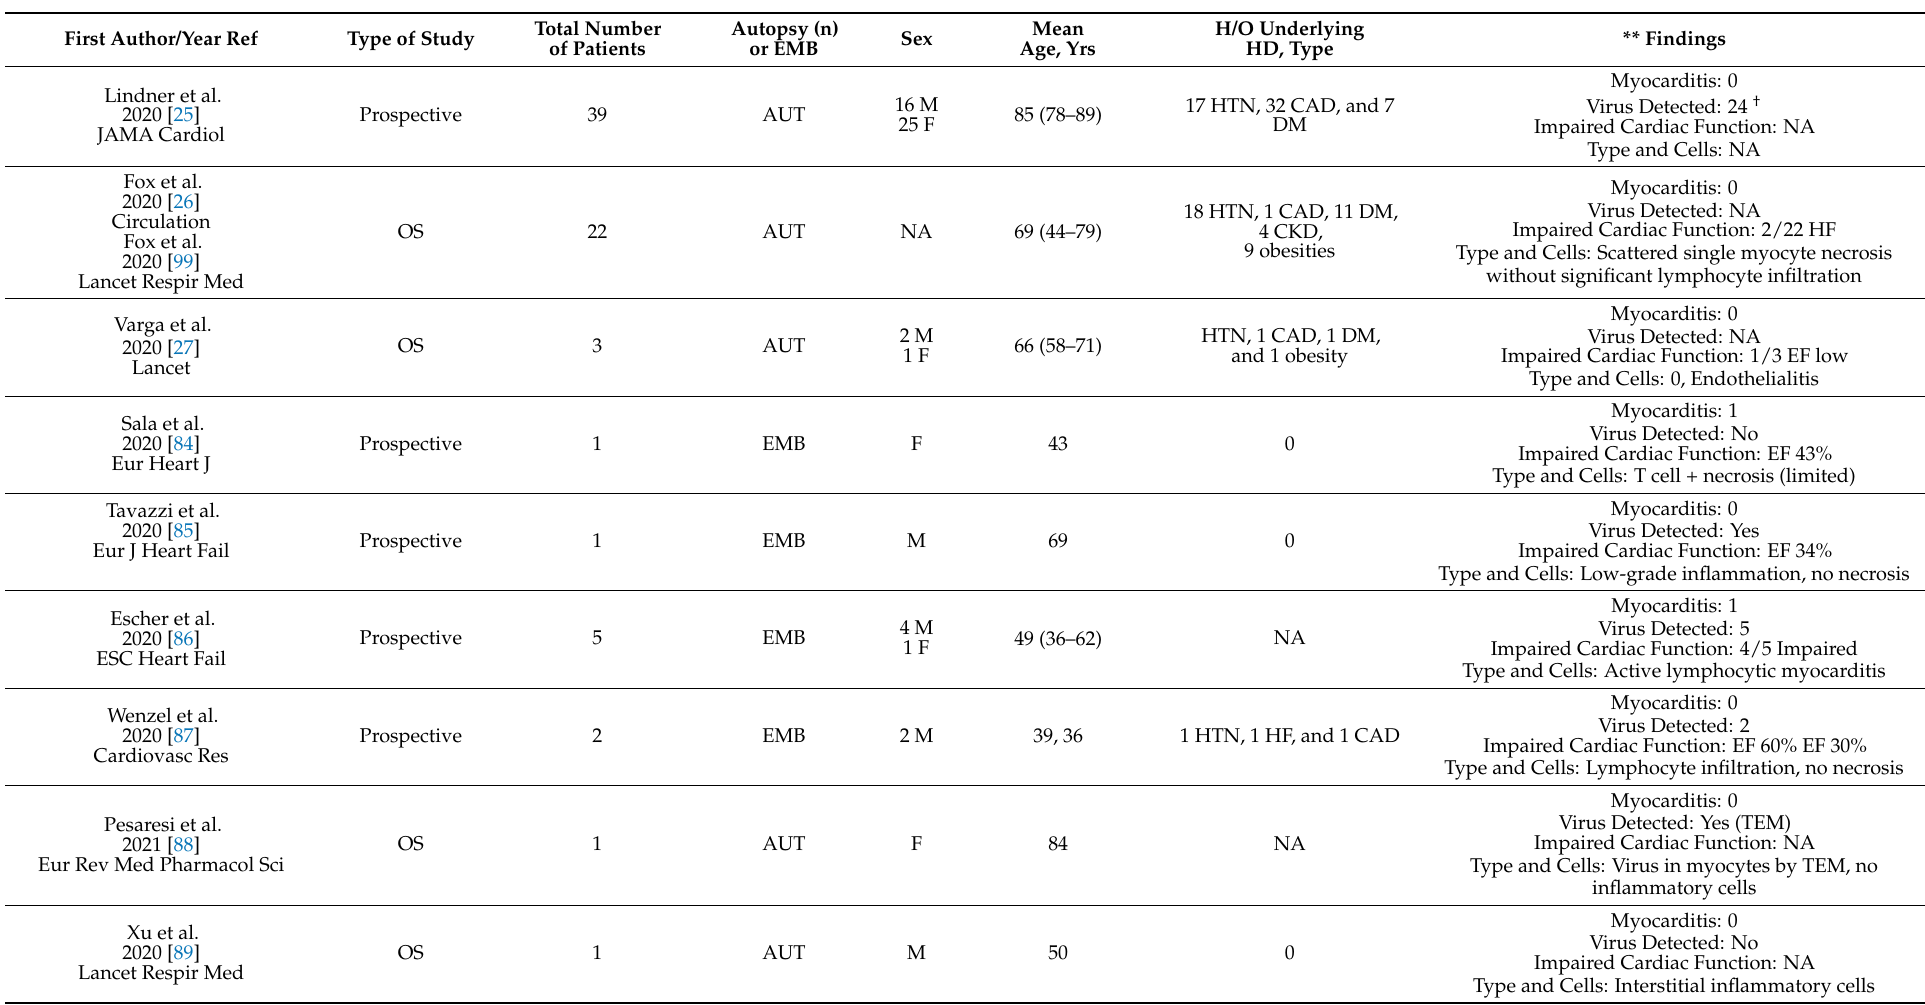
Table 1. Around 202 cases were studied with an autopsy, an endomyocardial biopsy, and CMRI. Myocarditis was diagnosed in 10 cases